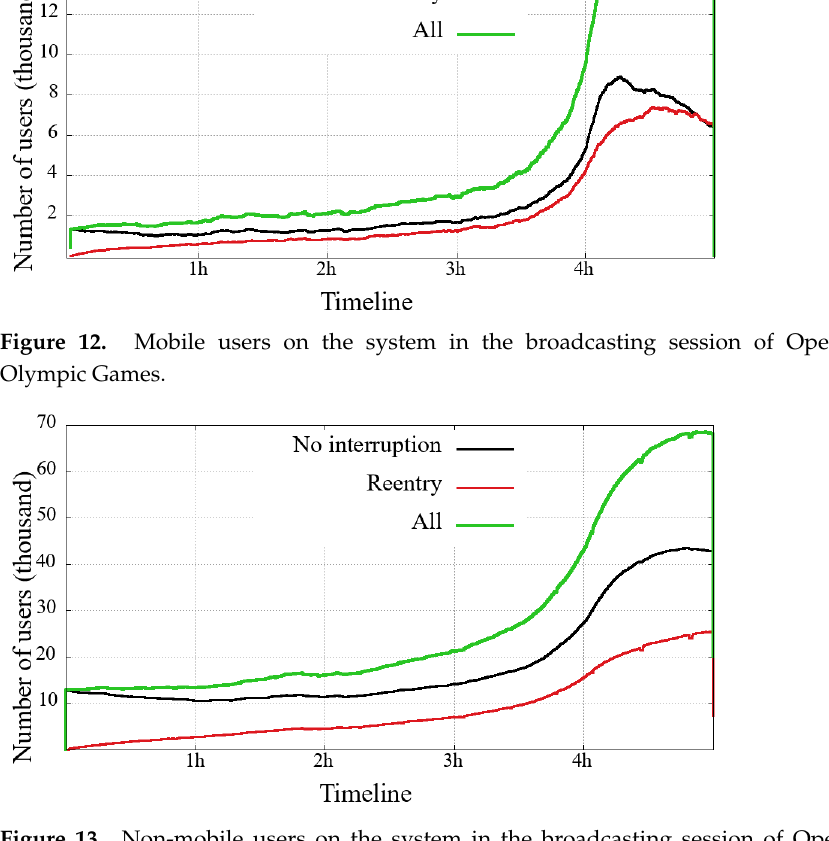
Figure 13. Non-mobile users on the system in the broadcasting session of Opening Rio 2016 Olympic